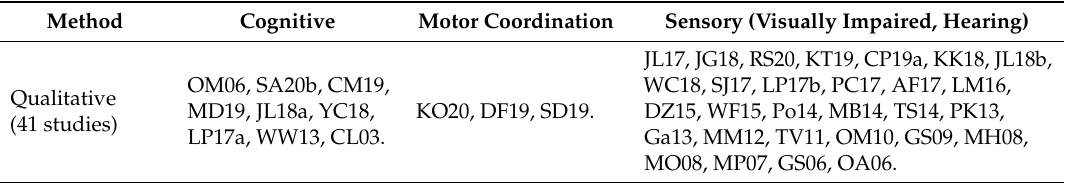
Table 8. Methods applied to the design of serious games by disability.